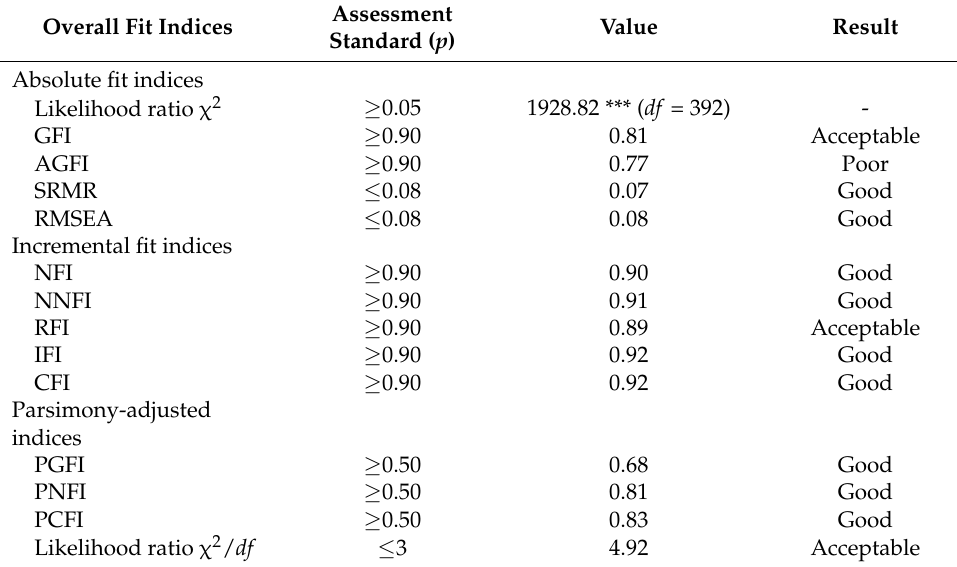
Table 1. Overall goodness-of-fit assessment of the